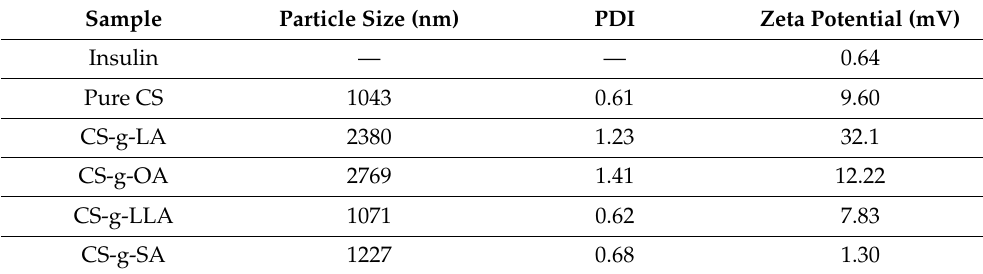
Table 1. Comparison of the particles size, PDI, and zeta potential data for various CS-based samples.